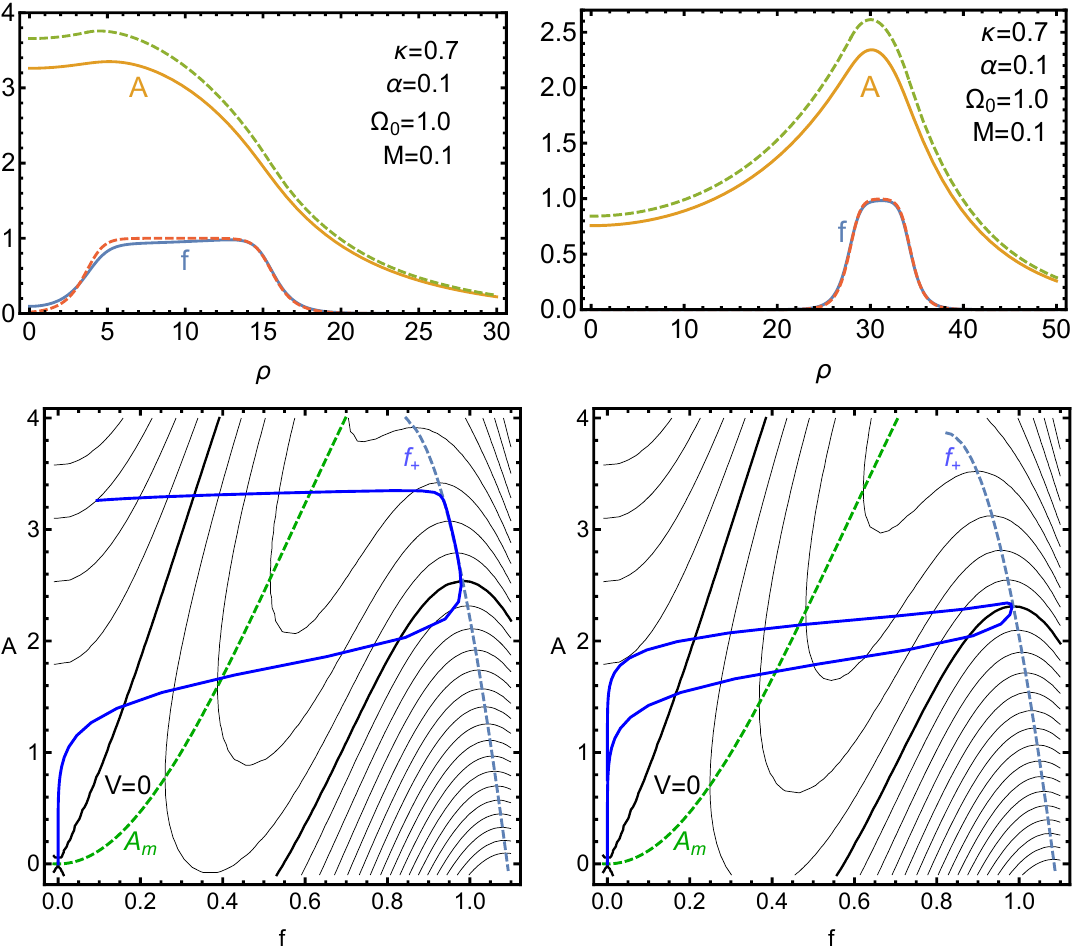
Figure 2 . Scalar and gauge field profiles for Proca Q-shells. Shown are the numerical f profile (blue), the numerical A profile (orange), as well as the analytic approximations from eqs. (4.2) and (4.3) of the same radii (dashed). A wide (narrow) Q-shell is shown on the left (right). The values of the f maximum f + (blue) and A minimum A m (green) are shown with dashed